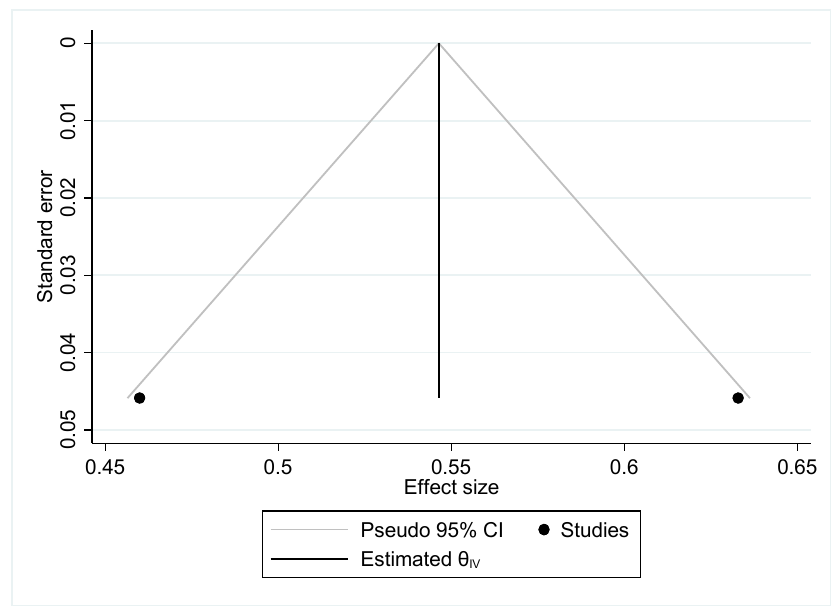
Figure 8. Funnel plot of the association between ethical concern and consumer purchase behavior.